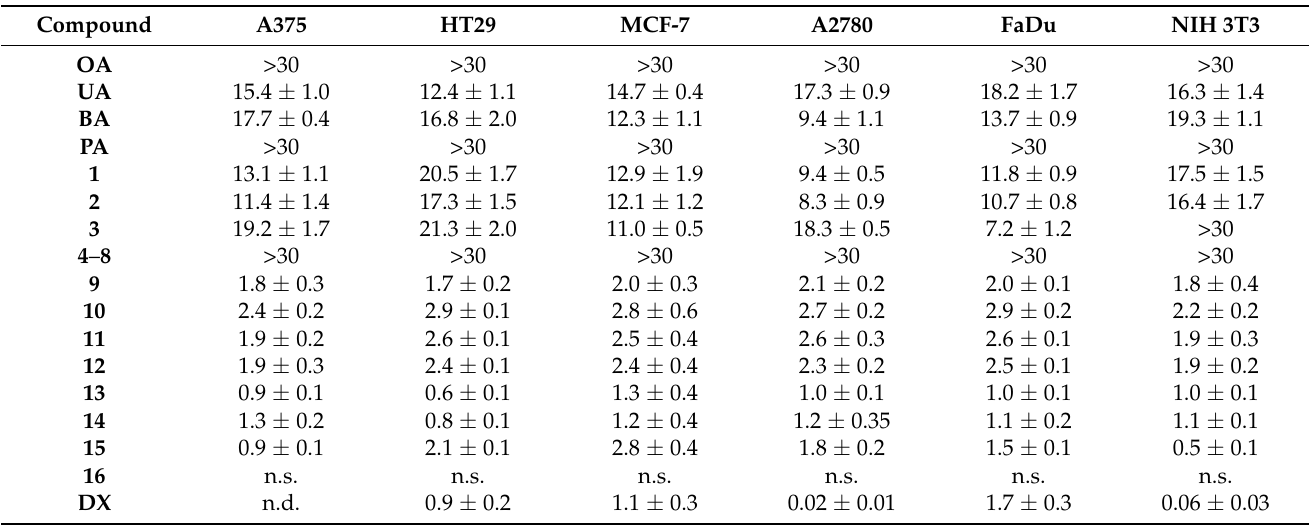
Table 1. Cytotoxicity of parent compounds OA , UA , BA , PA , acetates 1 – 4 , starting materials 5 – 8 as well as products 9 – 16 (EC 50 -values in µ M from SRB-assays) after 72 h of treatment, the values are averaged from three independent experiments performed each in triplicate, confidence interval CI = 95%; mean ± standard mean error); n.d. not determined; n.s. not soluble; betulinic acid ( BA ) and doxorubicin ( DX ) were used as positive controls. Cell lines: malignant: A375 (melanoma), HT29 (colon adenocarcinoma), MCF-7 (breast adenocarcinoma), A2780 (ovarian carcinoma), FaDu (hypopharyngeal carcinoma); nonmalignant: NIH 3T3